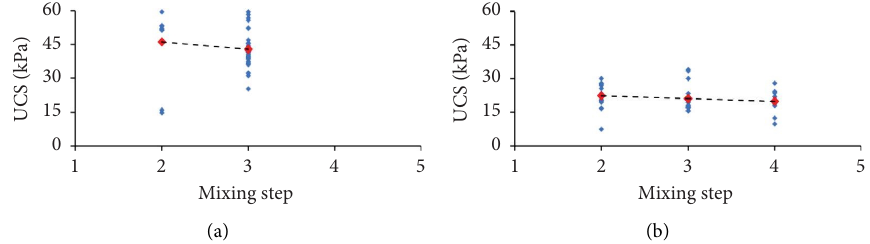
Figure 11: Predicted value of UCS based on mixing time: (a) frst phase (7% Multicem); (b) second phase (5% Multicem).